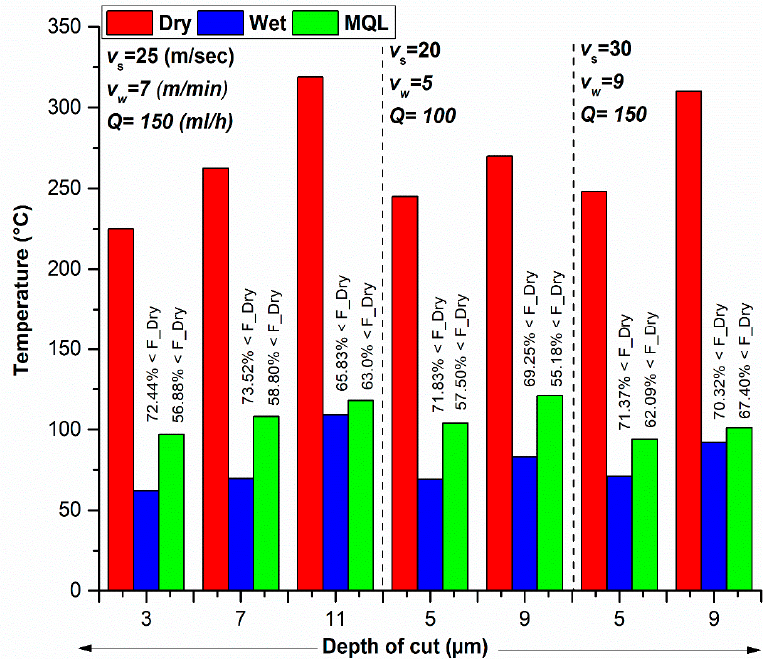
Figure 5. Comparison of temperature measurements in different cooling environments.